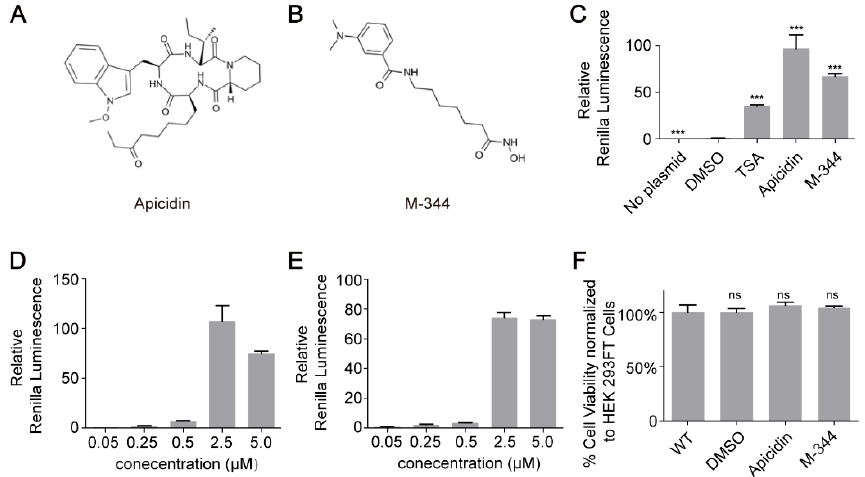
Figure 2. Detailed analyses of the two compounds. ( A , B ) The chemical structures of Apicidin ( A ) and M-344 ( B ). ( C ) Validation the improvement of Apicidin, M-344 and the positive control, TSA, using relative Renilla luminescence reporter assays. ( D , E ) Dose-dependent effects of Apicidin ( D ) and M-344 ( E ). ( F ) Cell viability was measured using MTS assays. All statistical analyses were determined using Student’s t-tests (ns, not significant; *** p < 0.001).